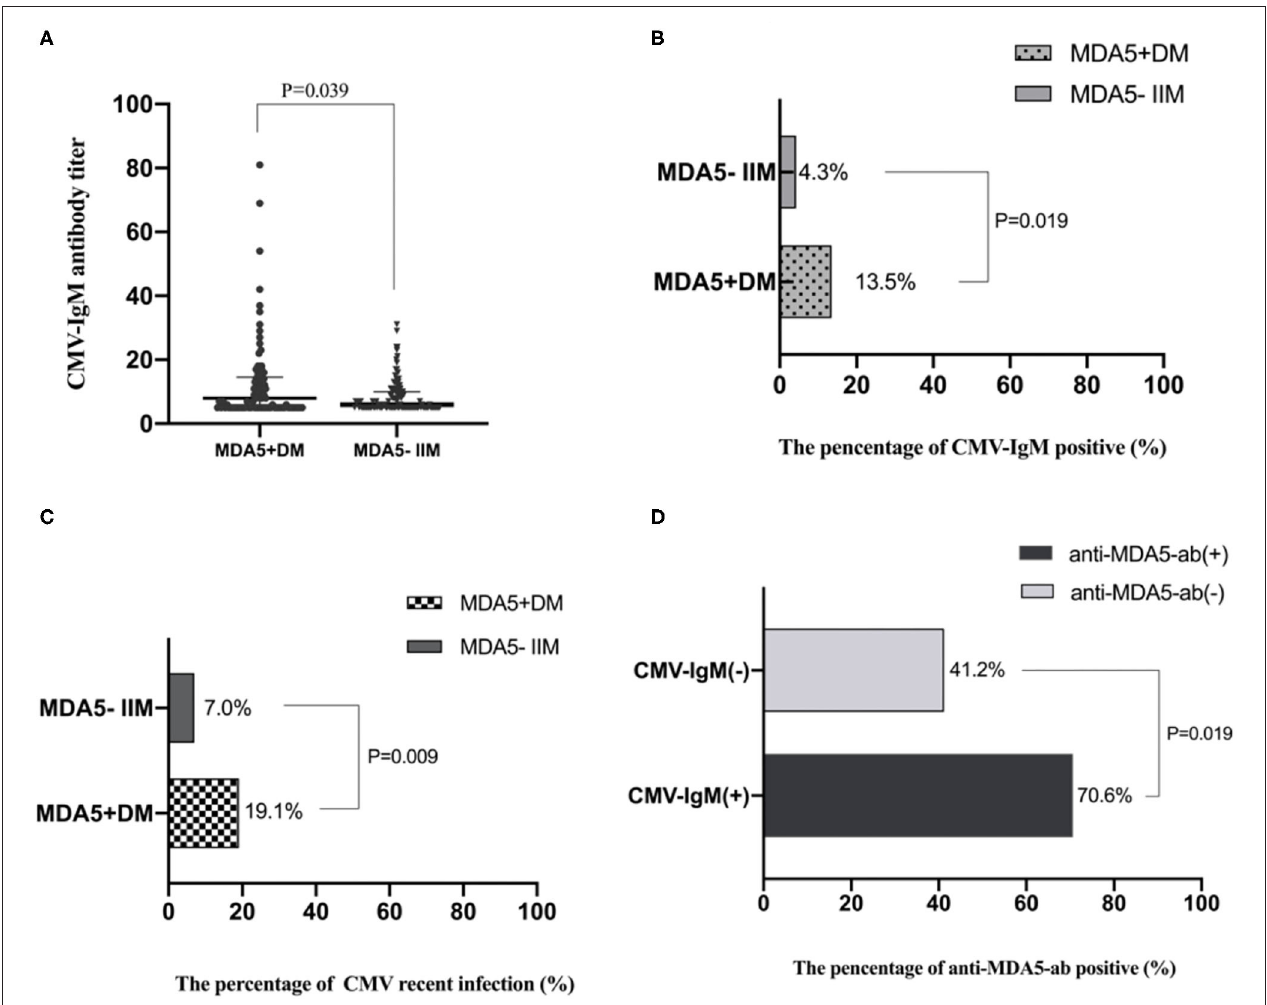
FIGURE 2 | CMV infection differences between MDA5 + DM and MDA5 − IIM patients. (A) Levels of CMV-IgM in MDA5 + DM and MDA5 − IIM patients; Levels of CMV-IgM were increased in MDA5 + DM compared with MDA5 − IIM patients (8 U/mL, IQR 5–14 U/mL vs. 6 U/mL, IQR 5–10 U/mL, p = 0.039). (B) The percentage of